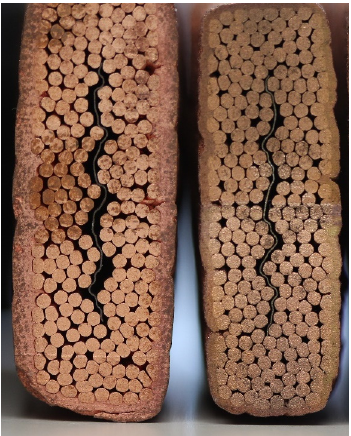
Figure 3 . Comparison between two dummy cables after Cu thermal spraying. On the left, the cable was coated as free-standing. On the right, an Al fixture was constraining it during coating.